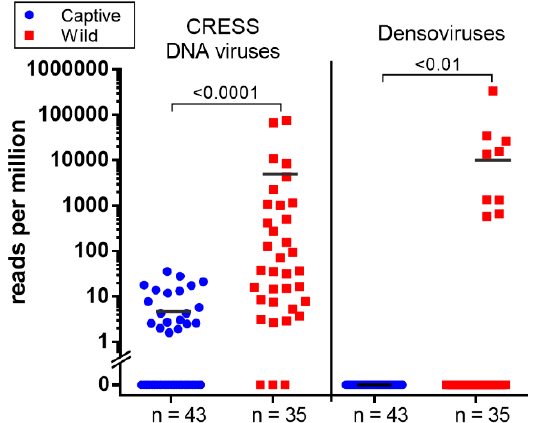
Figure 4. The scatter dot plot represents the relative abundance calculated as reads per million (RPM) of two group of viruses; CRESS DNA virus and densoviruses detected in wild and captive